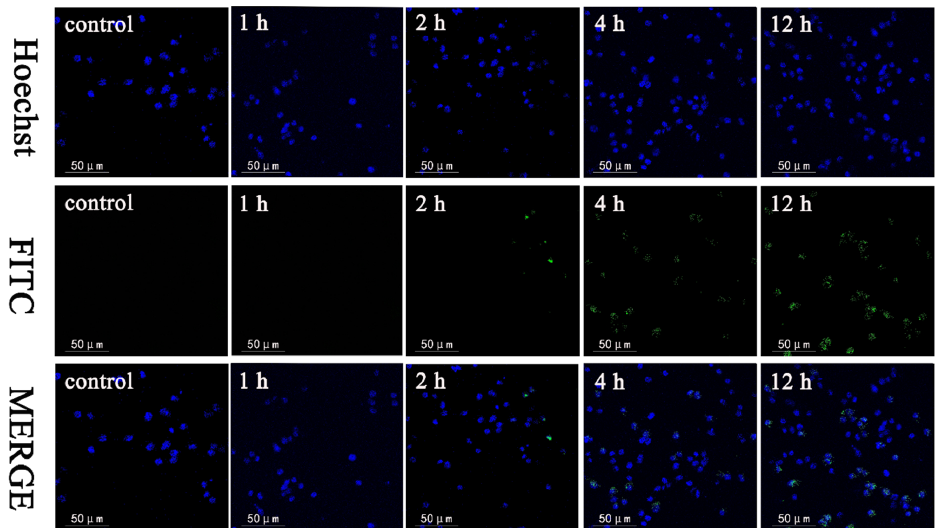
Figure 10. The hemolysis analysis ( a ) and cytotoxicity analysis ( b ) of NMMCNs-2, the in vitro anti- oxidation experiment analysis ( c ) and in vitro antitumor activity analysis ( d ) of Res–NMMCNs-2. The panel ( d ) inset is the analysis of the Hepa1-6 tumor cell inhibition rate of Res–NMMCNs-2 in vitro and ( e ) and ( f ) are schematic diagrams of the hemolysis experiment and cell uptake experi- ment, respectively.